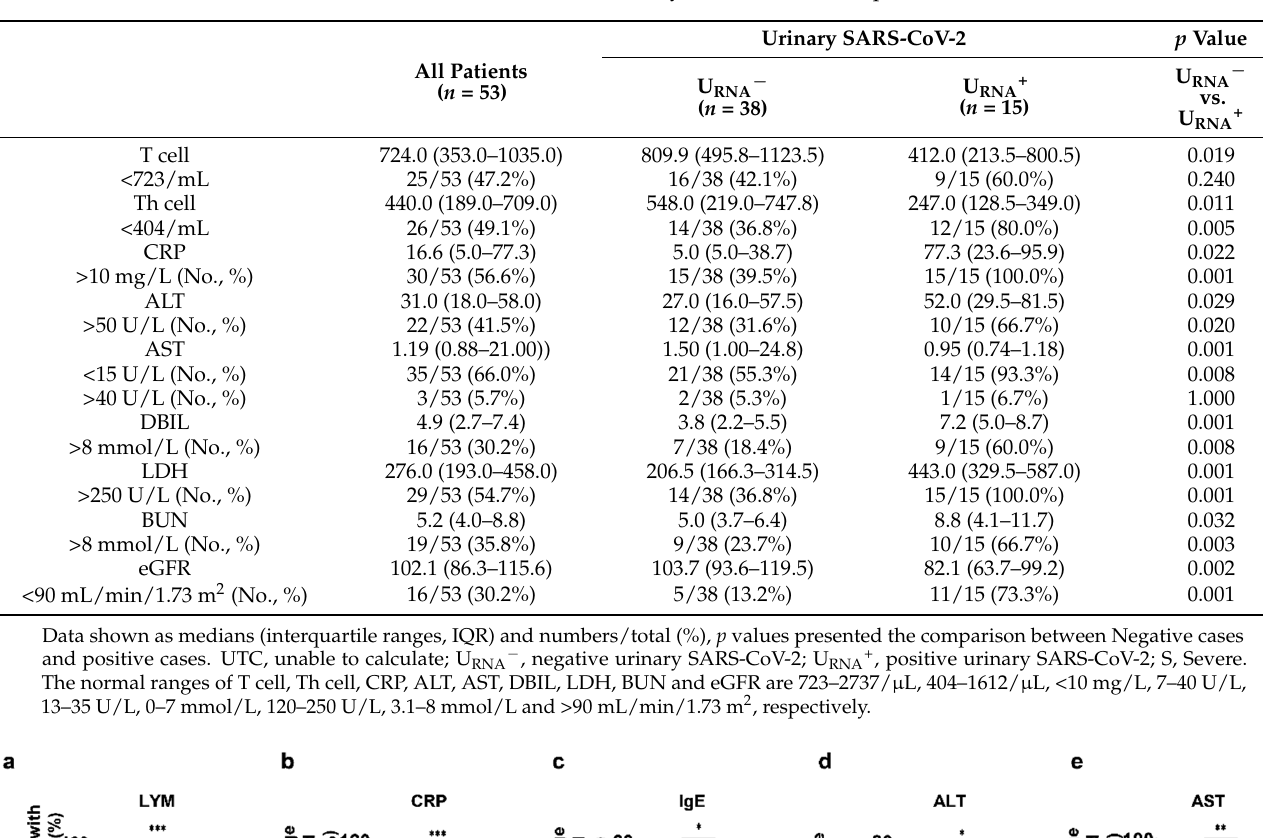
Table 1. Demographic and Clinical characteristics of 53 enrolled patients.